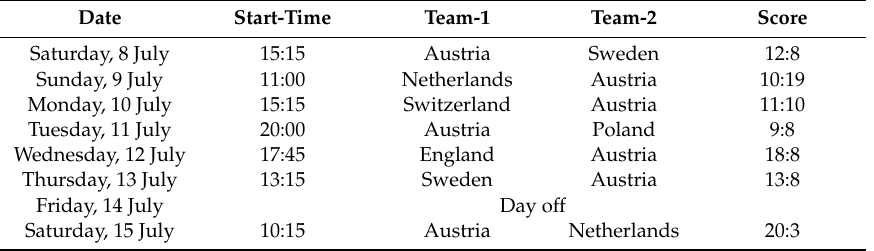
Table 1. Austrian National Team competition schedule at the European Indoor Lacrosse